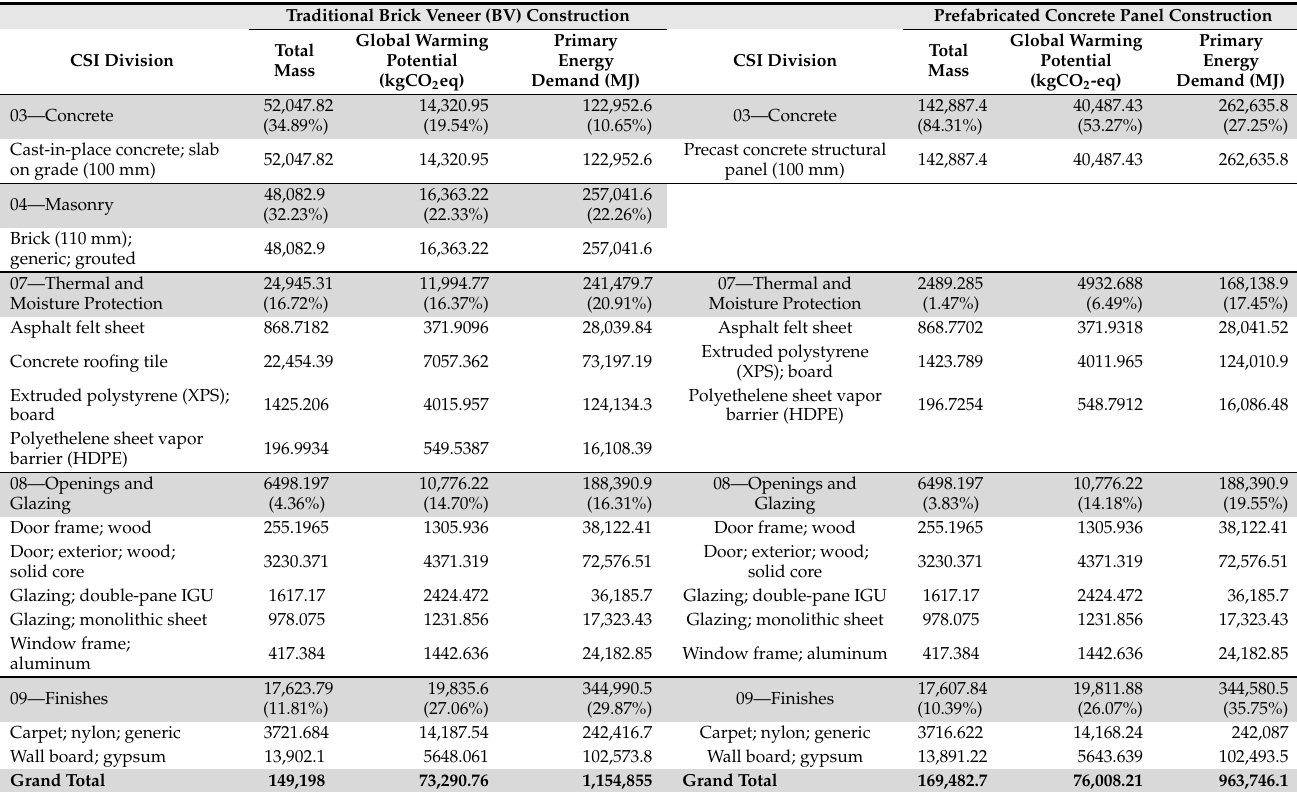
Table 5. Breakdown of total mass, CO 2 emission, and energy demand for traditional and precast concrete construction per the CSI materials